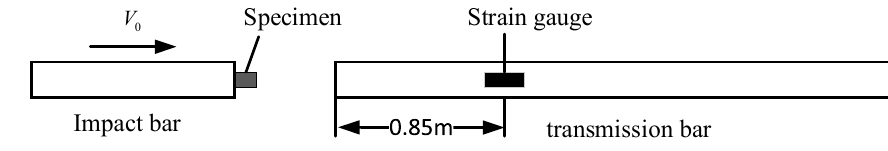
Figure 5. Stress test scheme of specimen impact end (test 2).